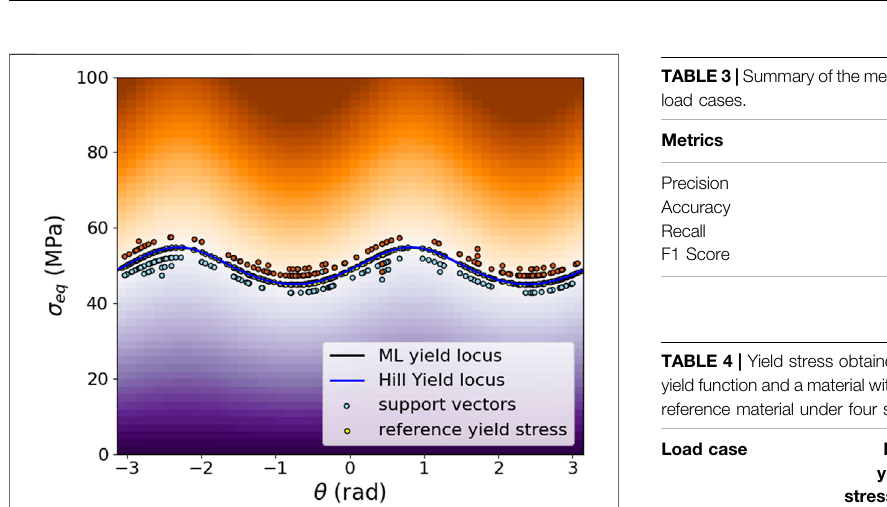
FIGURE 9 | (A) Precision and (B) Mean Absolute error after training with different number of load cases and a fi xed ratio of 2:1 for 6D to 3D load cases in full stress space and extra cases in principal space.